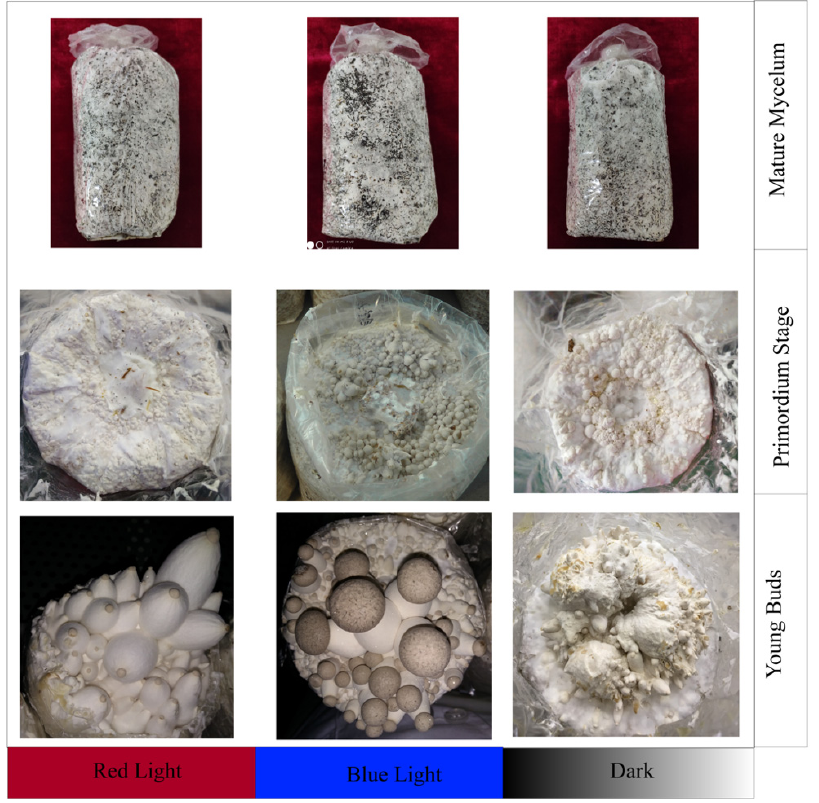
Figure 1. Morphological features of P. eryngii at each stage under different light treatments. The different light treatments used in the experiment, red light, blue light, and darkness, are presented along the abscissa. The different development periods are presented along the ordinate.